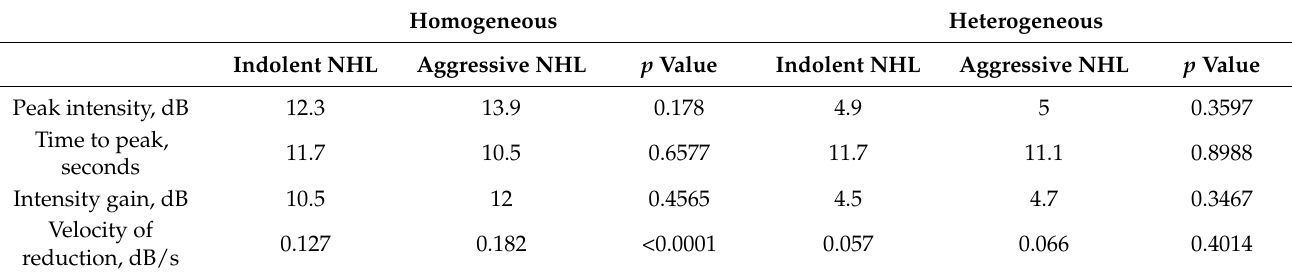
Table 4. The results of time–intensity curve analysis.